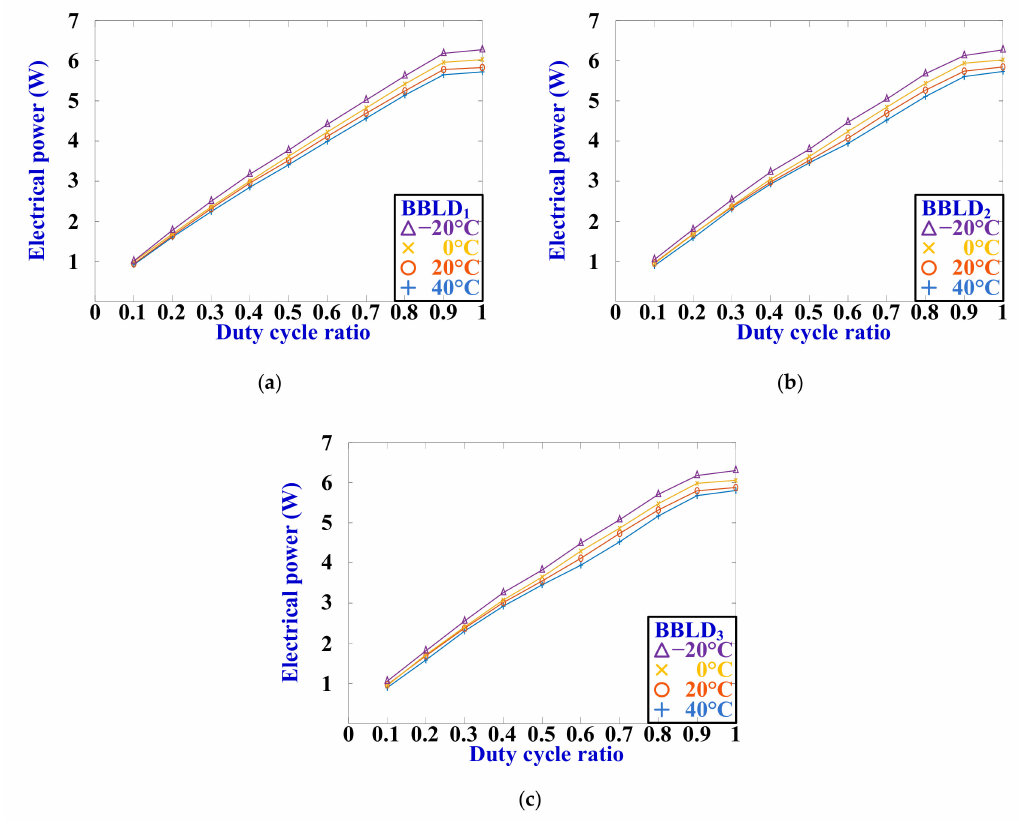
Figure 20. Variation of D pdcm to electrical power ( P e ( pdcm _ rms ) ) using RMS value calculation ( f s = 100 Hz). ( a ) BBLD 1 . ( b ) BBLD 2 . ( c ) BBLD 3